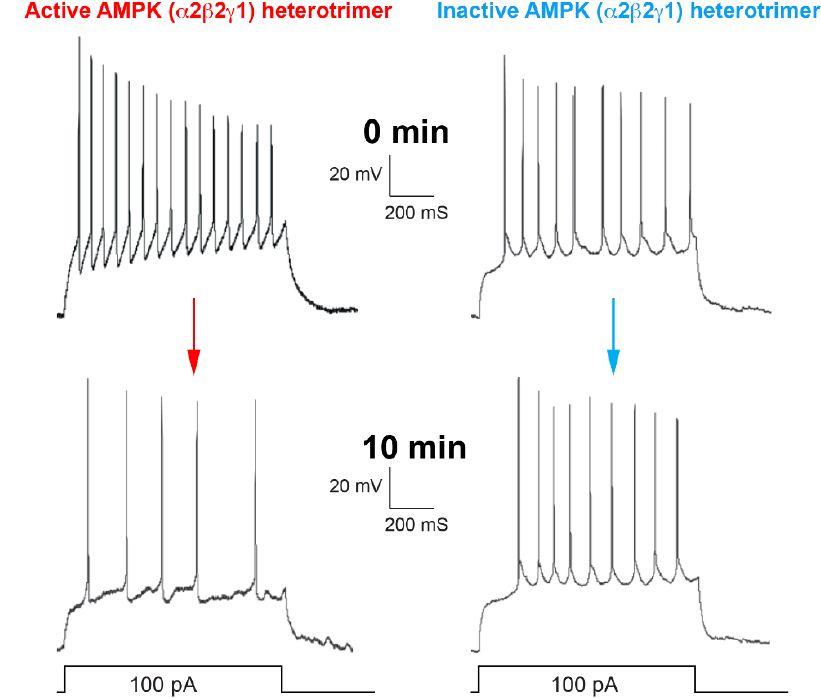
Figure 2. When the clock strikes 12 well cool off then. Active or inactive complexes of AMPK were applied intracellularly by dialysis from a patch pipette, and recordings taken at 0 min and 10 min after entering the whole-cell configuration. Action potentials were triggered by current injection. Created by Evans.